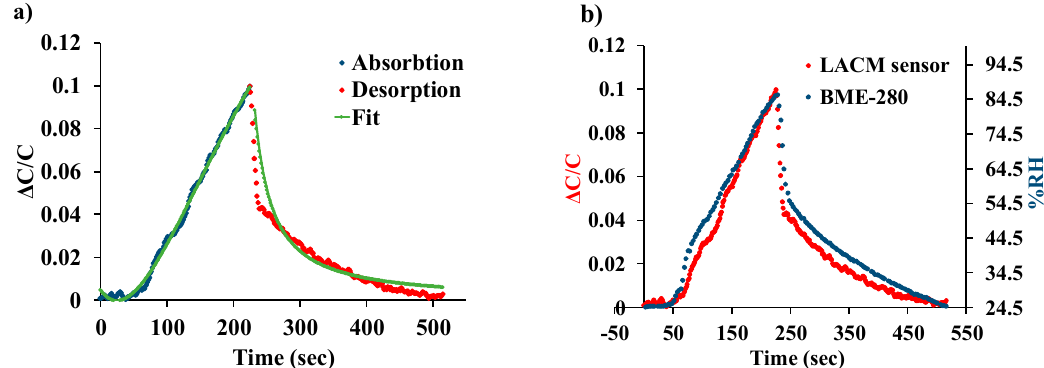
Figure 10. ( a ) Dynamic response of the LACM sensor curve fitted to Fick’s second law and the Polanyi–Wigner equation. ( b ) Comparison of the LACM sensor performance to a commercially available BME-280 reference chip.